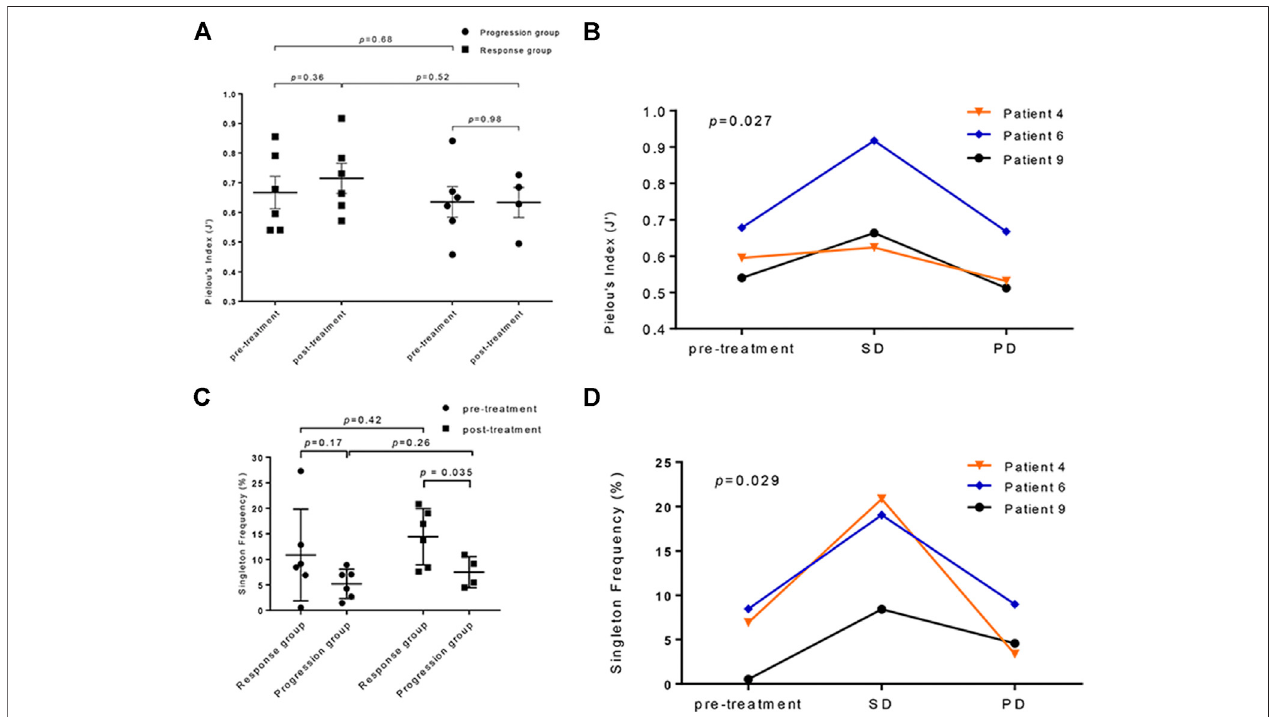
FIGURE3 | The analysisofthe T-cell receptor (TCR) repertoires diversity in anti – PD-L1 – treated patients. (A) The comparison ofTCRrepertoireevenness changes in the progression and response groups calculated by Pielou ’ s index ( p (cid:2) 0.36 in the response group; p (cid:2) 0.98 in the progression group; response vs. progression: pretreatment p (cid:2) 0.68, posttreatment p (cid:2) 0.52). (B) The dynamic observation of TCR repertoire evenness at different disease statuses of three patients who responded to atezolizumab ( p (cid:2) 0.027). SD: stable disease; PD: progressive disease. (C) The singleton frequency in the response and progression groups before ( p (cid:2) 0.17) and after ( p < 0.05) treatment. (pretreatment vs. posttreatment: p (cid:2) 0.42 in the response group, p (cid:2) 0.26 in the progression group). (D) The changes of the singleton frequency of the TCR repertoire in three patients responded to atezolizumab during treatment ( p (cid:2)